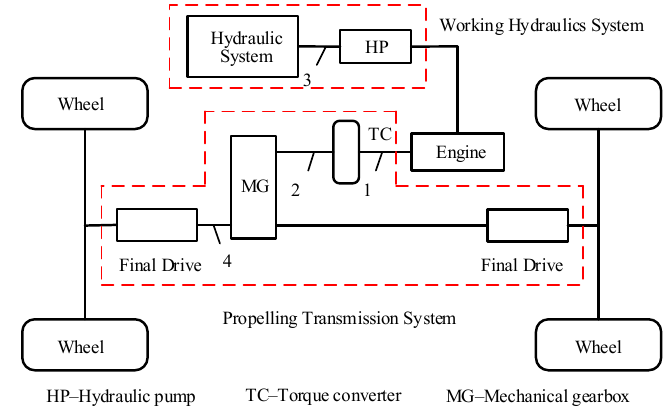
Figure 1. Wheel loader powertrain architecture.